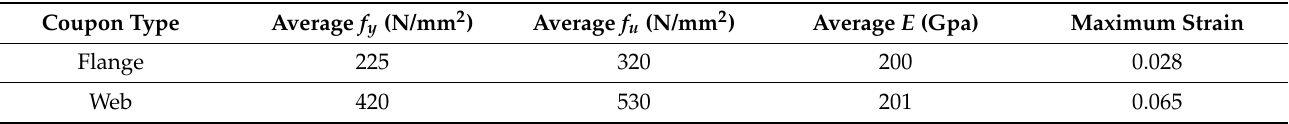
Table 2. Elastic moduli, maximum strains, and ultimate and yield stresses.